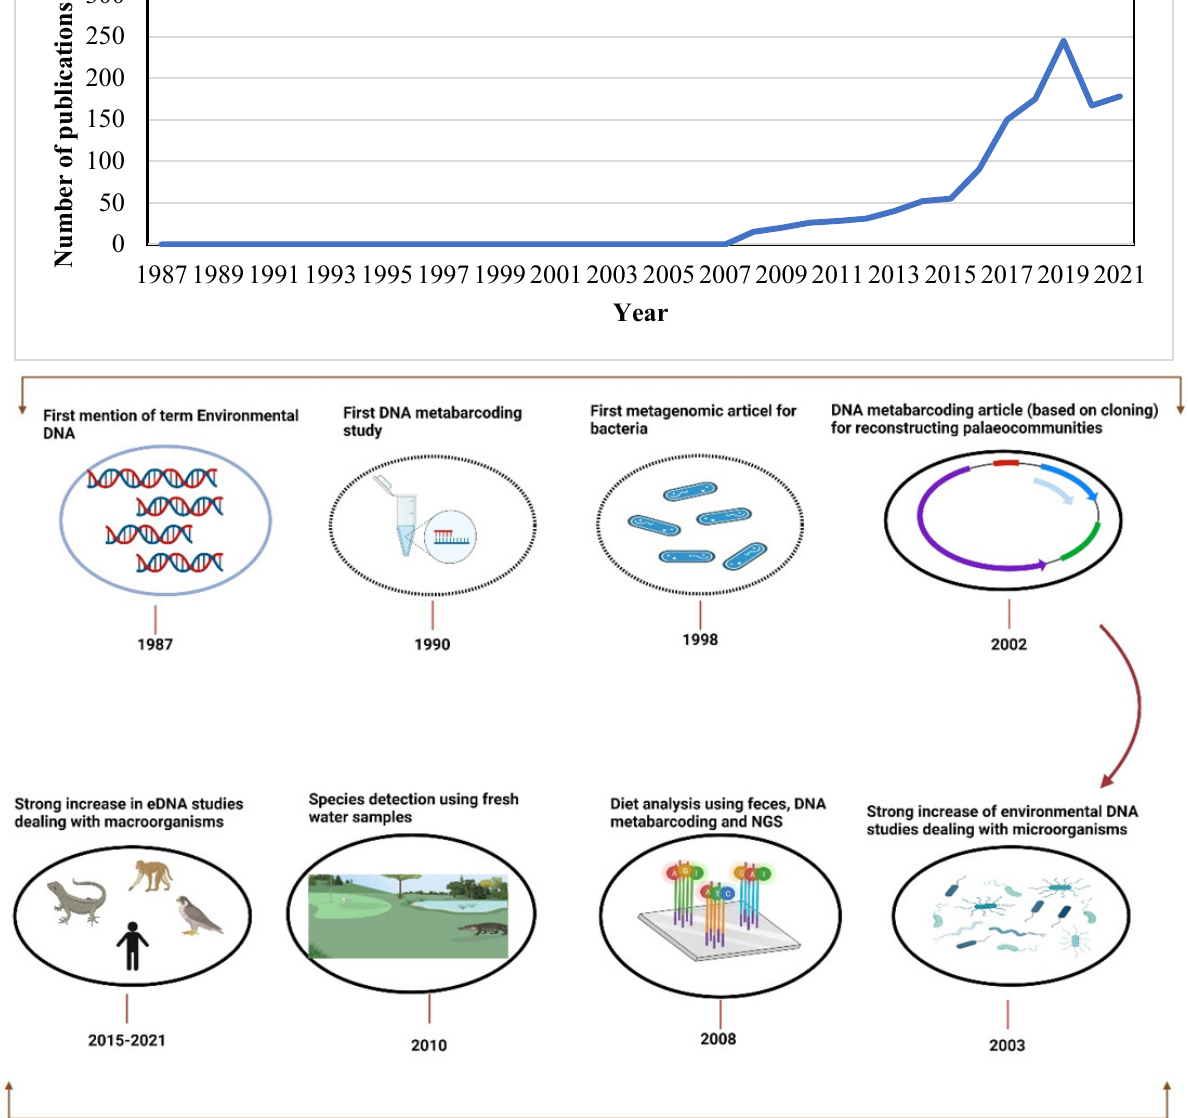
Figure 2. Overview and emergence of environmental DNA as a tool for biodiversity monitoring from “2008–2021”.